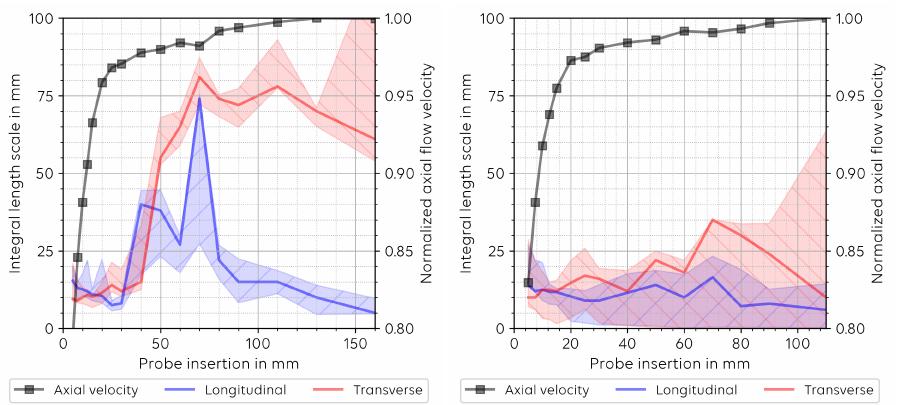
Figure 14. Turbulence integral length scale estimated for both longitudinal and transverse velocity components, and for two rotor speeds. The shaded regions indicate an approximated interval of confidence. ( Left ) η 1 ≈ 3800 RPM. ( Right ) η 2 ≈ 6840